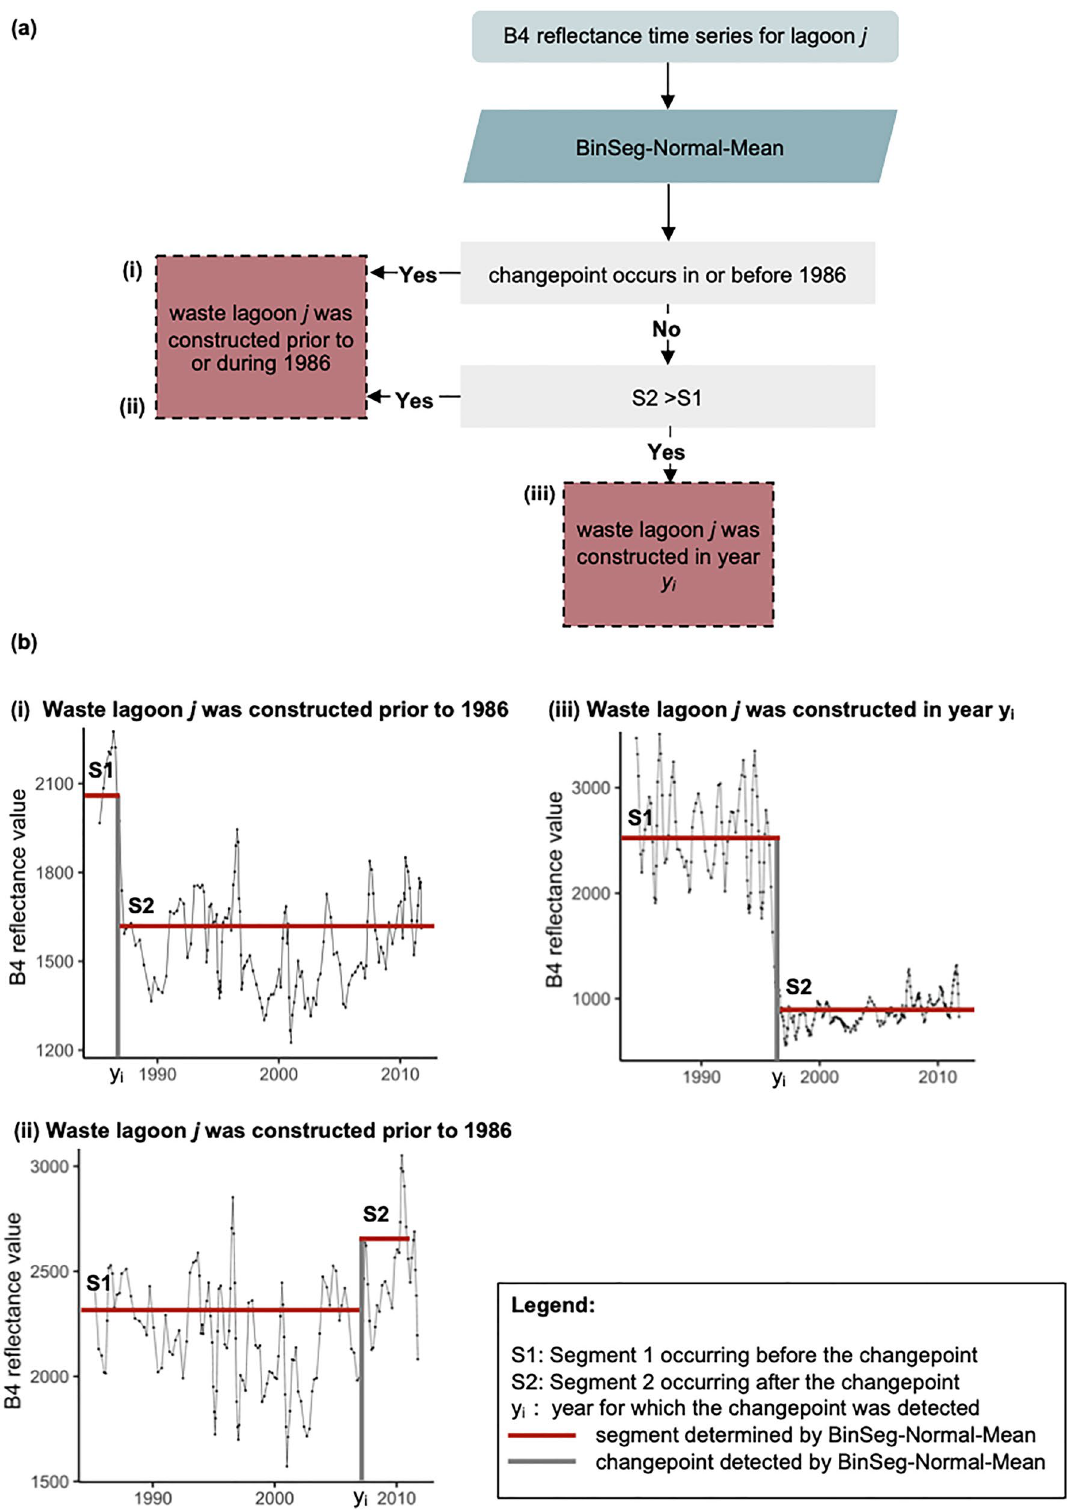
Figure 4. Changepoint detection algorithm for determining the year of construction of swine waste lagoons. Panel ( a ) summarizes the algorithm workflow, while panel ( b ) illustrates specific examples corresponding to each step (i–iii) in the